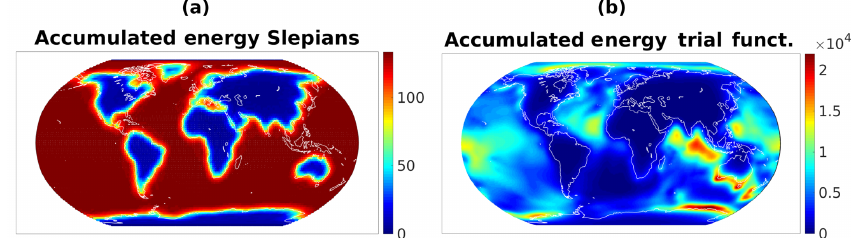
} (cid:96) = , B im 1 ,...,L (b) , with L (cid:96) (cid:96)